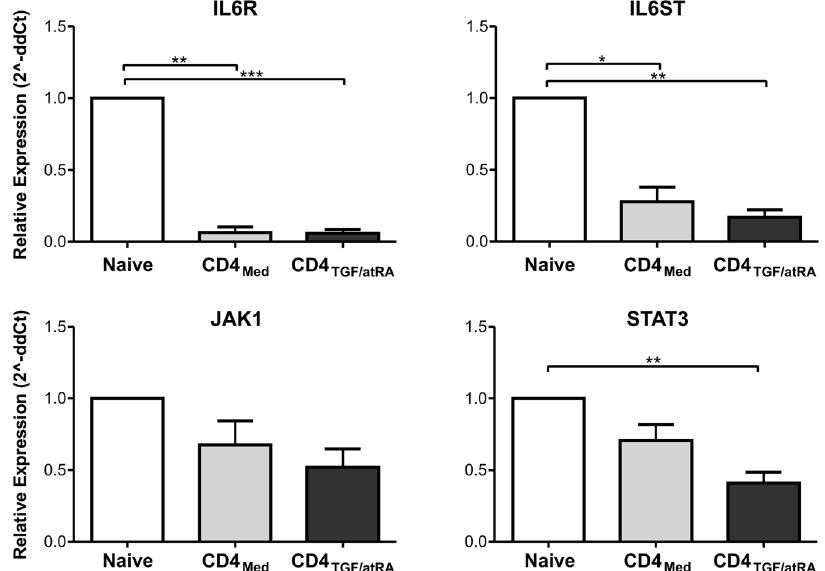
Figure 5. Inhibition of IL6/JAK/STAT signaling components by TGF-beta/atRA. Validation of microarray results by qPCR. Expression levels of IL6R, IL6ST, JAK1 and STAT3 were evaluated by real-time qPCR in naïve T-cells, CD4 Med and CD4 TGF/atRA . Bars indicate mean and SEM of three separate experiments. The statistical test used to compare the expression level was non-parametric Mann-Whitney tests. * p <